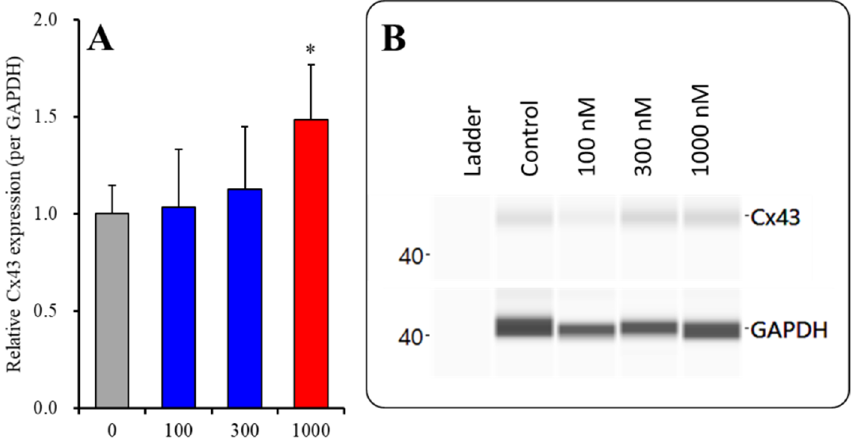
Figure 4. Concentration-dependent effects of subchronic administration of ZTP on Cx43 protein expression in the cytosol fraction ( A ) and their pseudogel images, using capillary immunoblotting ( B ). Ordinate: mean ± SD (n = 6) of the relative protein level of Cx43 (per GAPDH). Concentration-dependent effects of ZTP (100, 300 and 1000 nM) on Cx43 expression in the cytosol fraction of the primary cultured astrocytes were analysed by one-way ANOVA with Tukey’s (wholly significant difference) post hoc test (* p < 0.05 vs. ZTP free (0)).